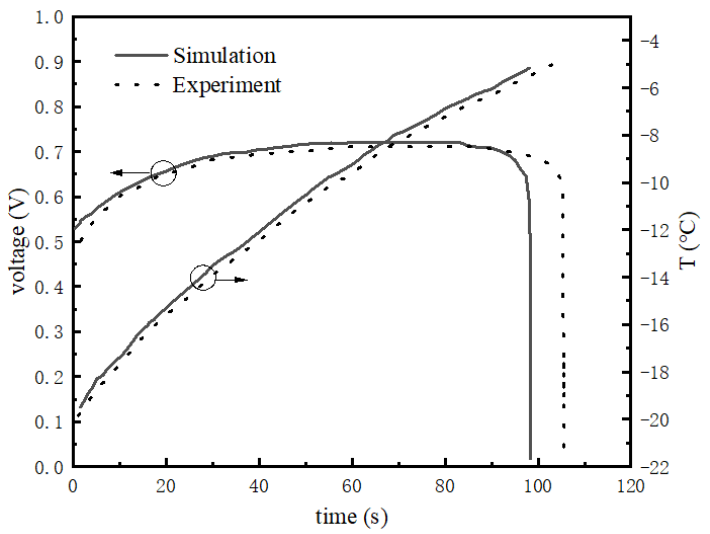
Figure 3. Temperature and voltage variation curve of stack under − 20 °C startup.